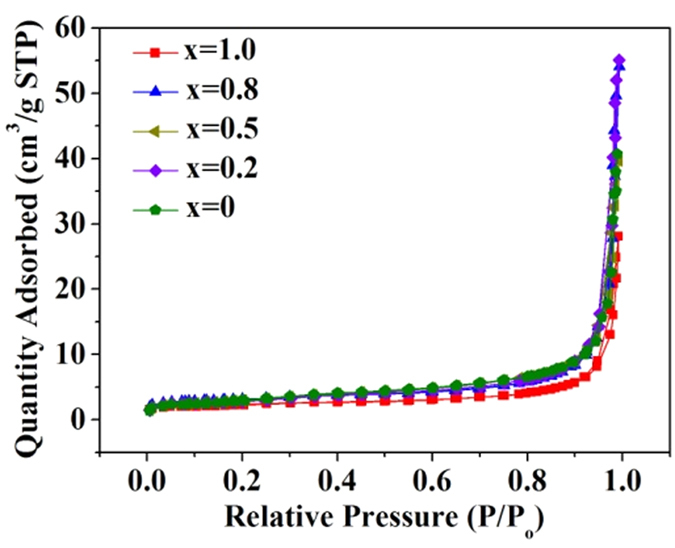
Nitrogen adsorption-desorption isotherm plot of the as-prepared BiOBrxI1−x nanoplates with x = 1.0, 0.8, 0.5, 0.2, and 0.